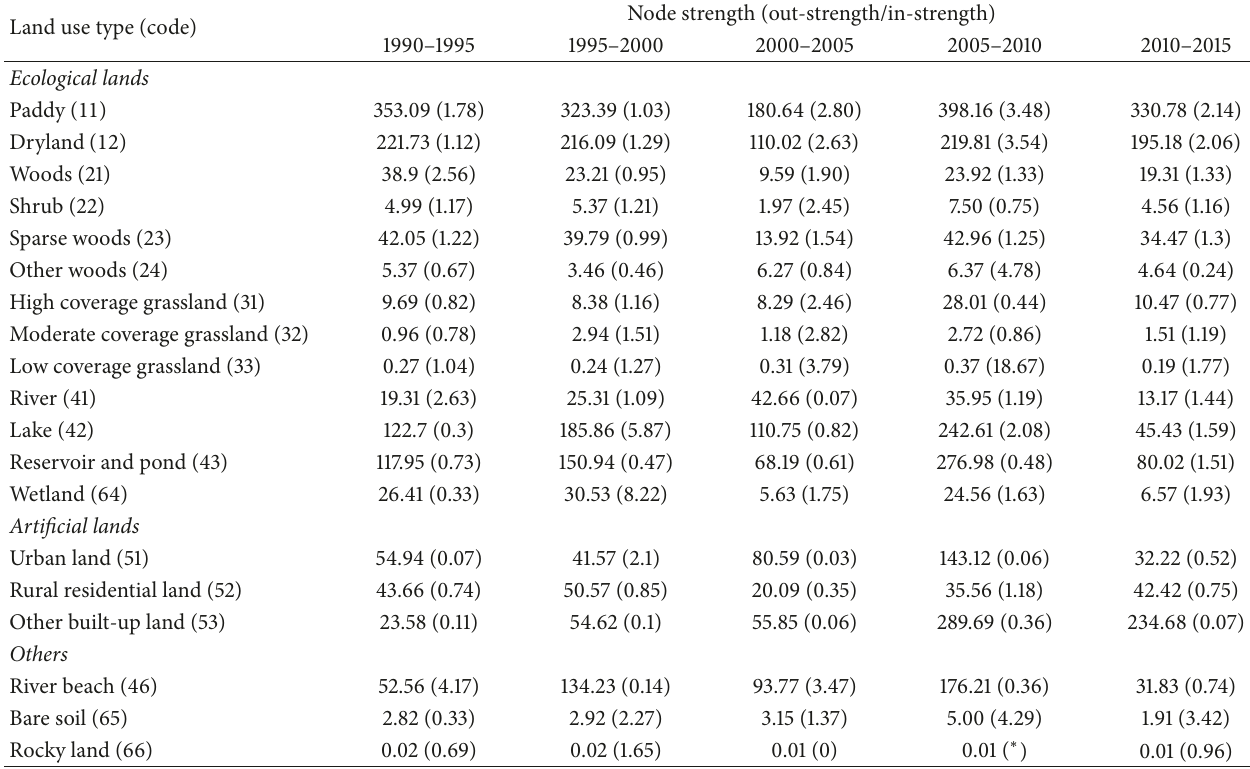
Table 3: Node strength † and the division of the out-strength and in-strength in land system networks in different periods. Land use type